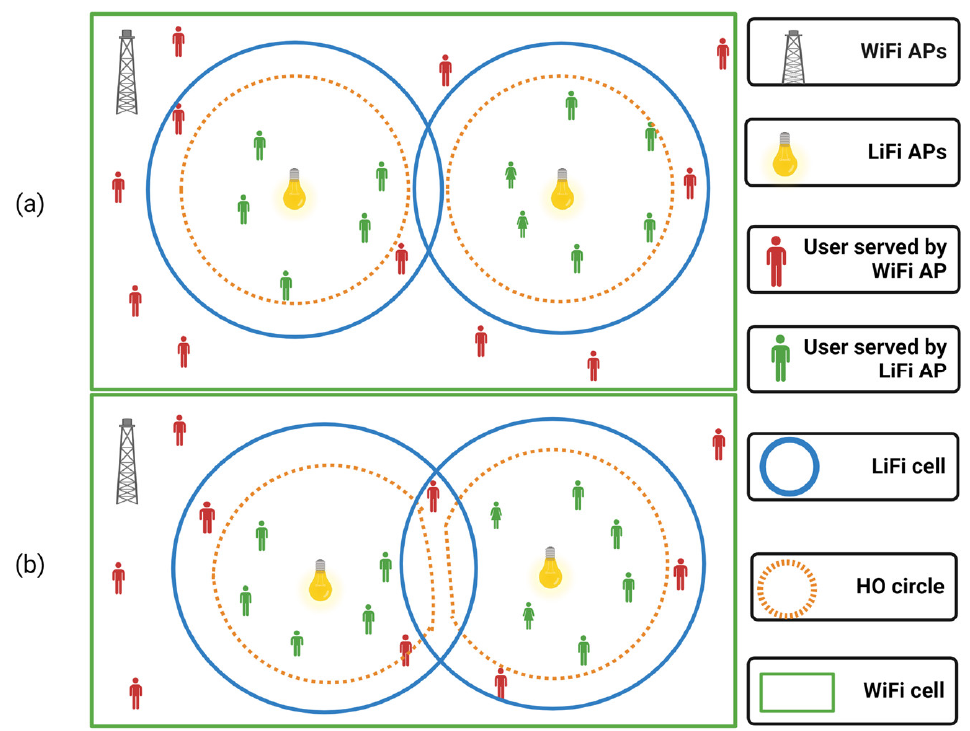
Figure 2. HO Circle Illustration. ( a ) HO circle does not overlap, ( b ) HO circle overlapped with an- other.